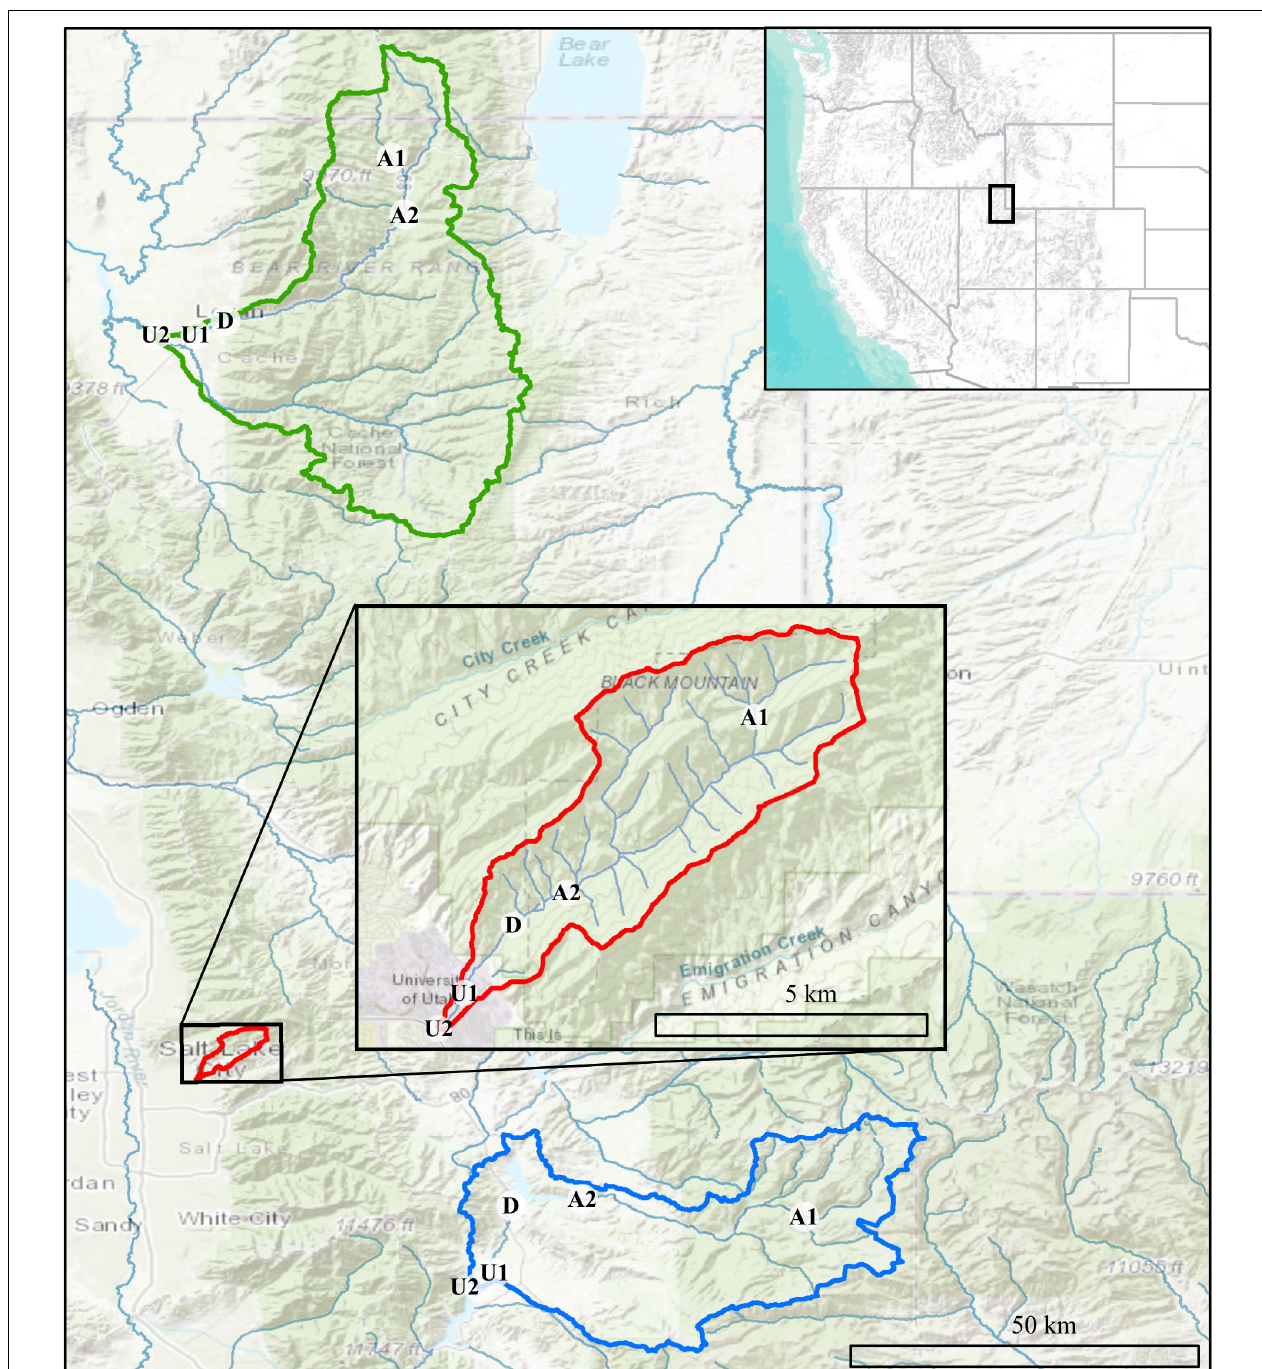
FIGURE 2 | Map showing Logan (green), Red Butte (red), and Provo (blue) Watersheds in the Wasatch Range Metropolitan Area and locations within watersheds where bacterial communities and water quality data were collected. Location markers indicate position relative to man-made reservoirs and urban centers in all three watersheds: A, Above; D, below Dam; U, Urban. Site metadata is included in Table 1 . Sources: ESRI, USGS, NOAA.